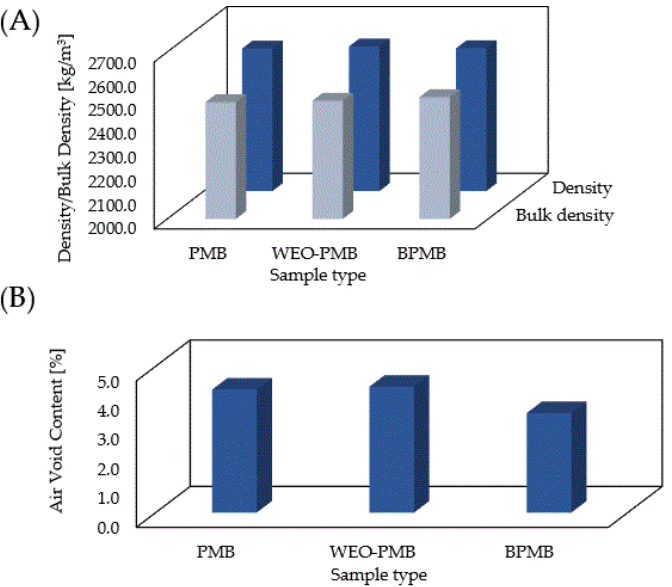
Figure 7. Density/bulk density ( A ) and air void content ( B ) of the PMB, WEO-PMB and BPMB mix- tures.